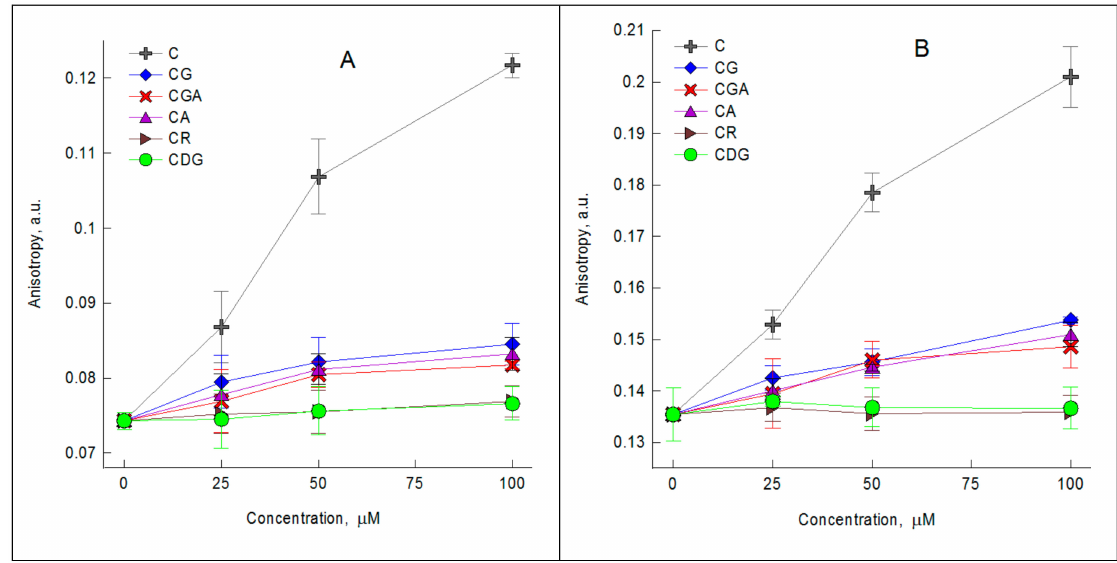
Figure 1. The values of anisotropy of diphenylhexatriene (DPH) probe determined for 1-palmitoyl- 2-oleoylphosphatidylcholine (POPC) large unilamellar vesicles without and with addition of 25 µ M, 50 µ M and 100 µ M of cyanidin and its glycosides at: ( A ) 35 ◦ C and ( B ) 15 ◦